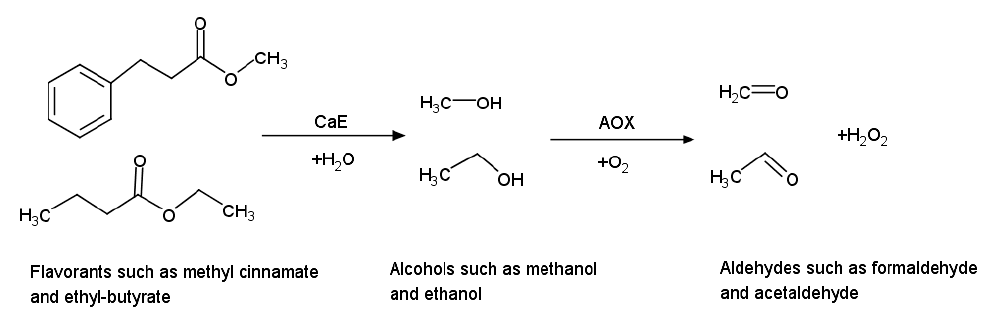
Figure 7. The reactions used for flavorants detection with a bienzymatic biosensor: the flavorants hydrolysis followed by alcohols oxidation and hydrogen peroxide detection.